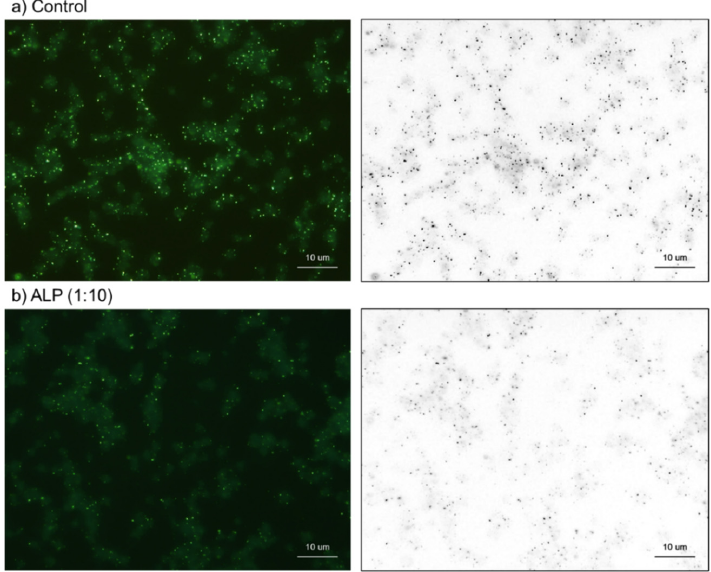
Figure 8. The effects of ALP on platelet polyP. Fixed platelets were treated with 0.3 U/mL (1:10) ALP for 8 h ( b ). The control was incubated in the specific buffer without ALP ( a ). Bar = 10 μ m. Similar results were observed in four other independent experiments.